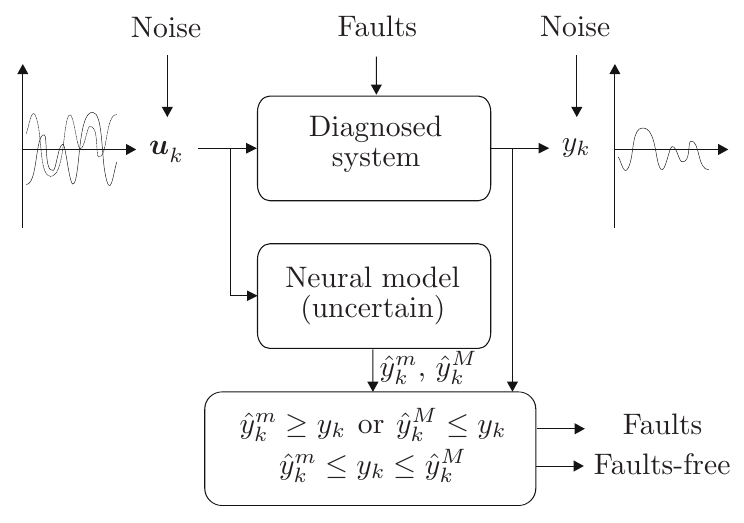
Figure 2. The diagram of the neural model-based Robust Fault Detection